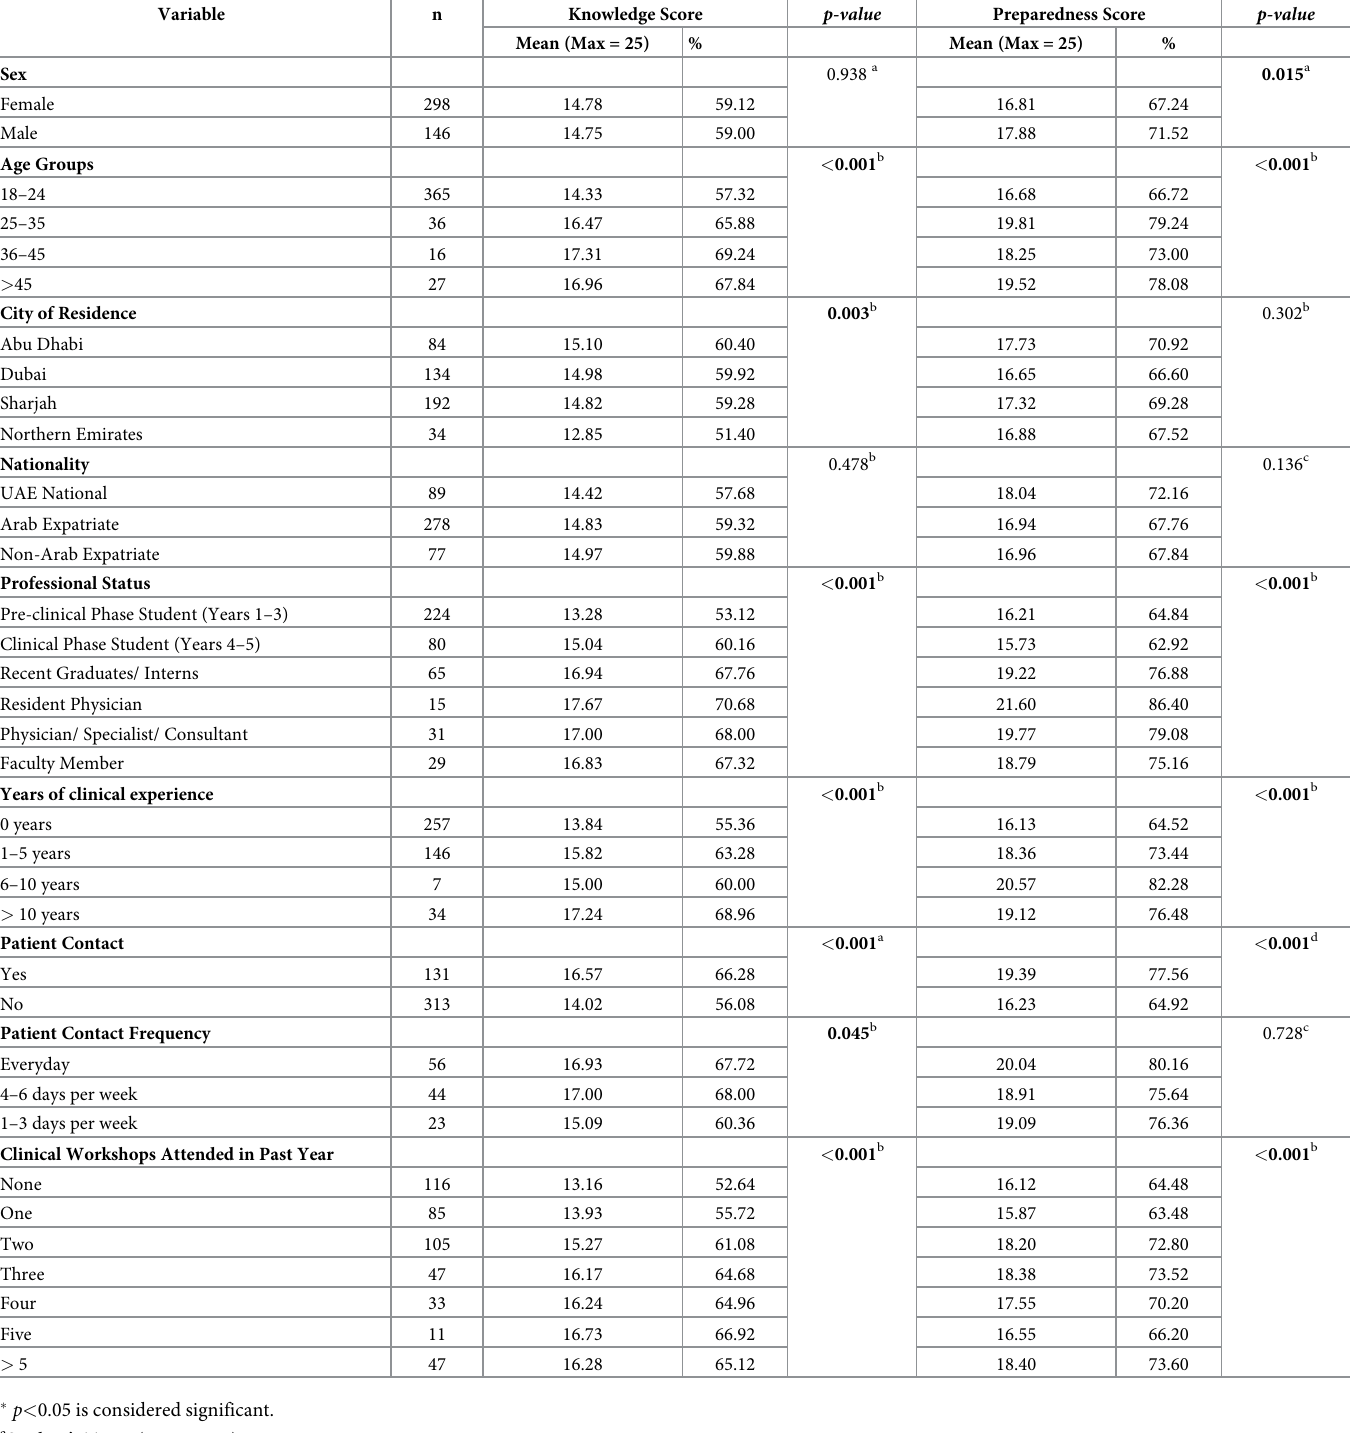
Table 2. Knowledge and preparedness among different socio-demographic